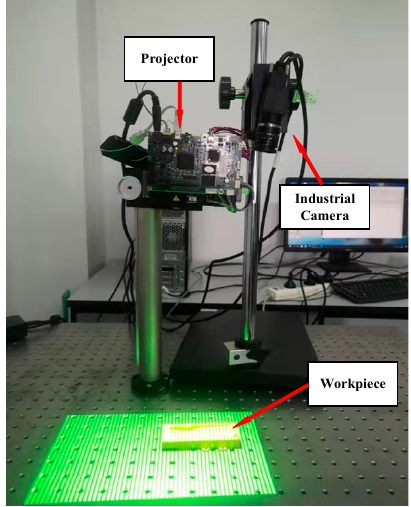
Figure 11. Structured light-based measurement system.